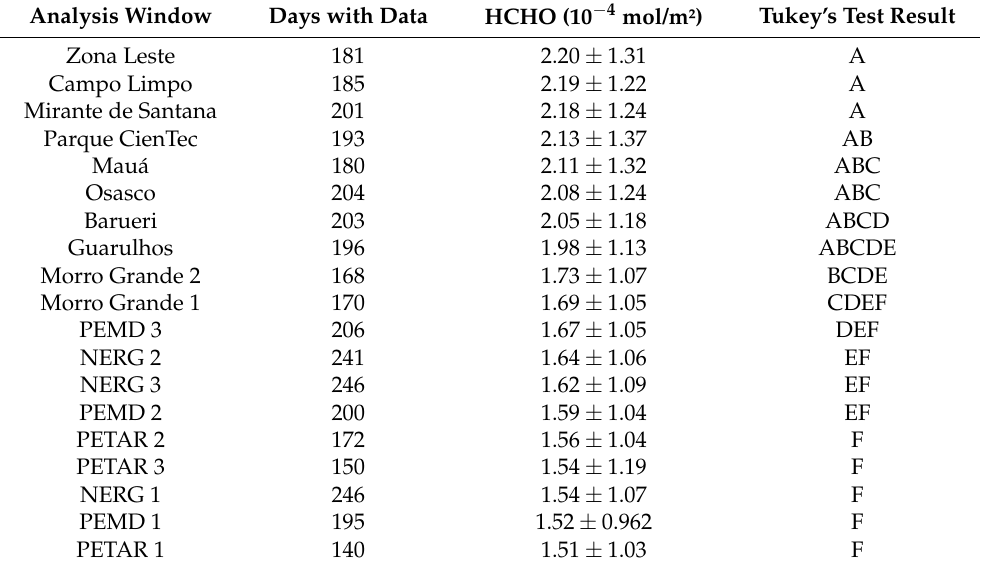
Table 1. Number of days with valid data, annual arithmetic mean and standard deviation of HCHO columns (12 p.m.–4 p.m. local time, from January to December 2020) and Tukey’s test results for each analysis window. Windows with the same letter in the Tukey’s test result presented statistically equal mean HCHO concentrations.